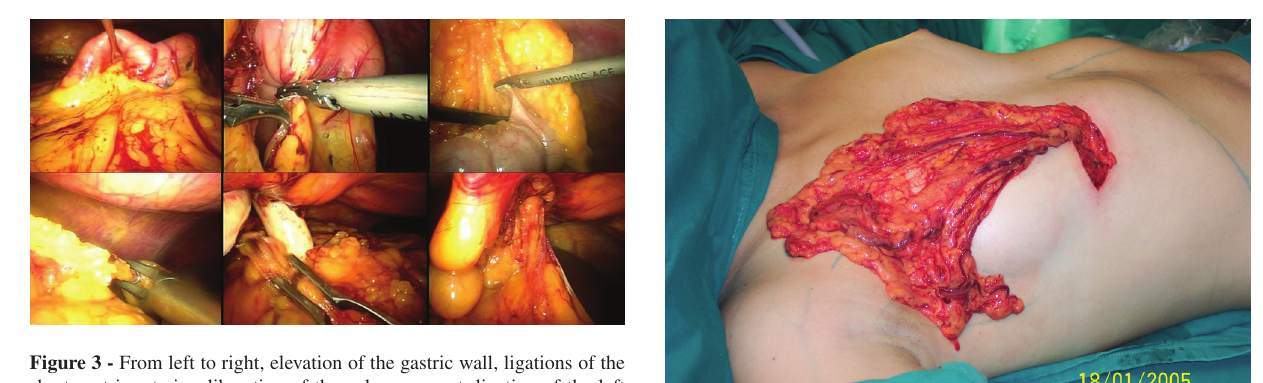
Figure 3 - From left to right, elevation of the gastric wall, ligations of the short gastric arteries, liberation of the colon segment, ligation of the left gastro-epiploic artery, incision in the peritoneum to pull the omentum flap (using a finger maneuver) from the abdominal cavity to the breast region. Figure 4 - The omentum flap on the thoracic wall.